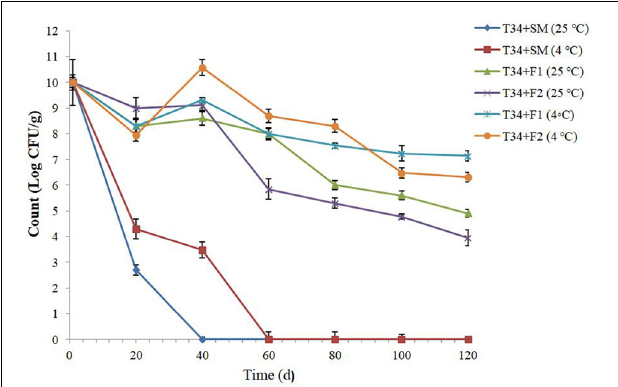
FIGURE 2 | Storage stability of lyophilized and covered T34 probiotic strain with different Tarkhineh formulations during 120 days storage at 25 ◦ C and 4 ◦ C. T34: Lactococcus lactis . F1: plain Tarkhineh. F2: turmeric Tarkhineh. SM: 10% skim milk + 5% sucrose. Values shown are means ± standard deviations ( n =